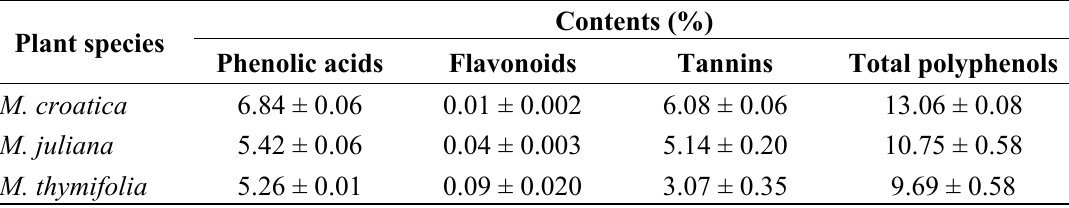
Table 1. Contents of phenolic acids, flavonoids, tannins and total polyphenols in three selected Micromeria